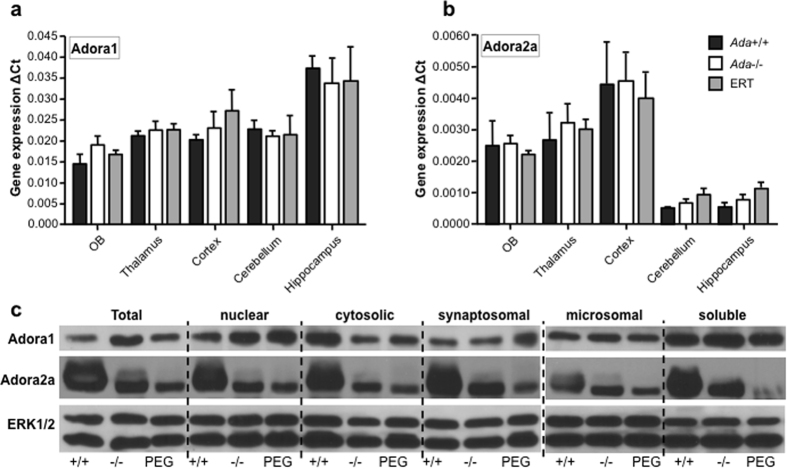
Alterations in adenosine A1 and A2a receptor expression in Ada−/− mice.(a) TaqMan gene expression analyses for adenosine receptor A1. Olfactory bulbs, thalamus, cortex, cerebellum and hippocampus ex vivo; ΔCt normalized for GADPH endogenous control (average of 6 experiments + SEM). (b) TaqMan gene expression analyses for adenosine receptor A2a. Olfactory bulbs, thalamus, cortex, cerebellum and hippocampus ex vivo; ΔCt normalized for GADPH endogenous control (average of 6 experiments + SEM). (c) Representative cropped Western Blot analysis for A1 (36 kDa), A2a (45 kDa) and ERK1/2 (42/44 kDa) as housekeeping control on brain fractions from a Ada+/+, Ada−/− and Ada−/− mouse treated with ERT. Total protein preparation, cell debris and nuclei (P1) and postnuclear supernatant (S1), synaptosomal fraction (P2) and supernatant (S2), microsomal pellet (P3) and post-microsomal soluble protein fraction (S3).